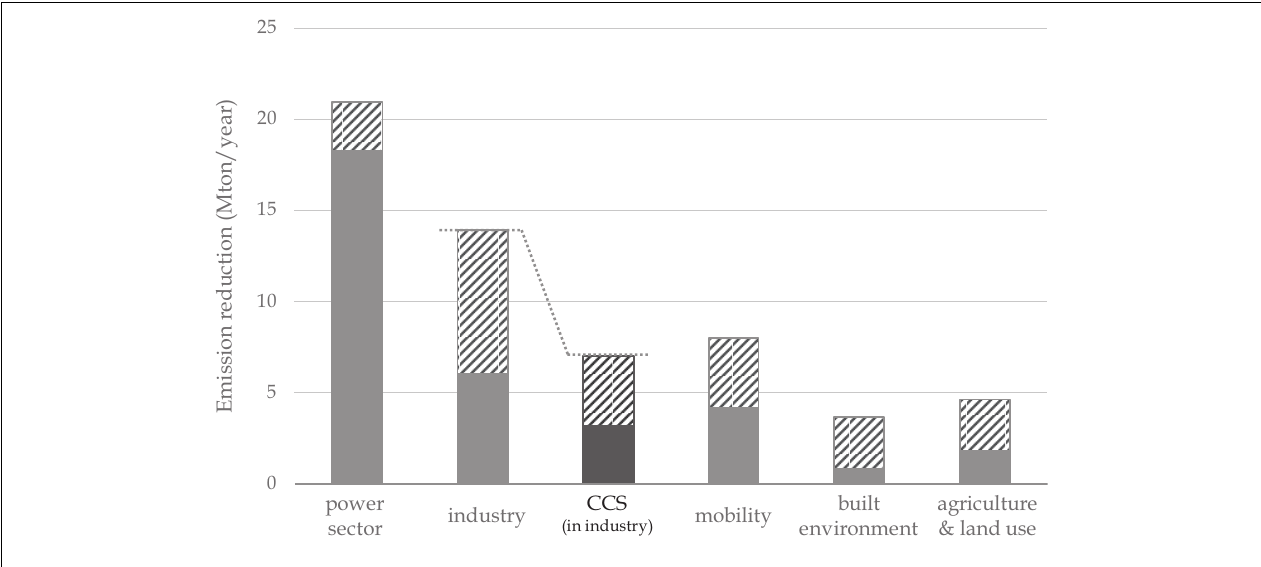
FIGURE 1 | Projected annual emission reductions in Netherlands in 2030, based on the Dutch 2019 Klimaatakkoord, according to analysis of the Dutch Environmental Planning Agency (PBL). The Klimaatakkoord allocates the emission reduction task to five sectors of the energy economy (gray). CCS is part of industry. The hashed areas indicate the uncertainty between low and high estimates for 2030 (PBL,